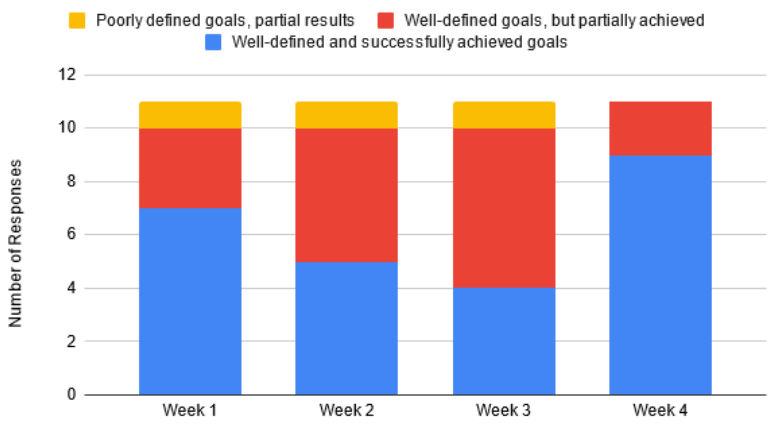
Figure 9. Project evolution in 4